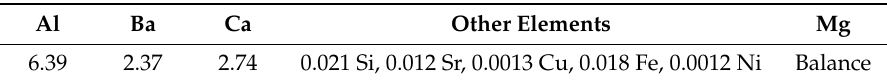
Table 1. The chemical composition of the ABaX633